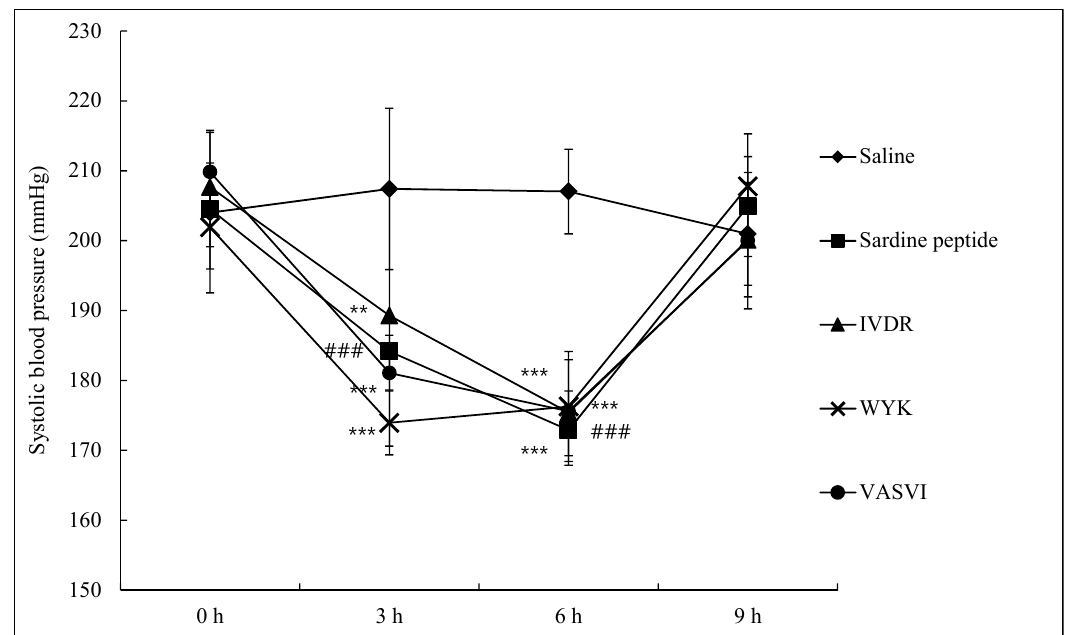
Figure 3. Change in systolic blood pressure (SBP) after oral administration of the peptides in SHRs. ( ♦ ) Control (saline); ( ■ ) positive control (peptide derived from Sardino melanostictus ); ( ▲ ) IVDR; (×) WYK; ( ● ) VASVI. All the samples including the positive control were orally administrated to the SHRs at 50 mg/kg. The values are means ± SD of triplicate experiments. ### p < 0.001 (positive control compared to non-treated group), ** p < 0.01, *** p < 0.001 (sample group compared to non-treated